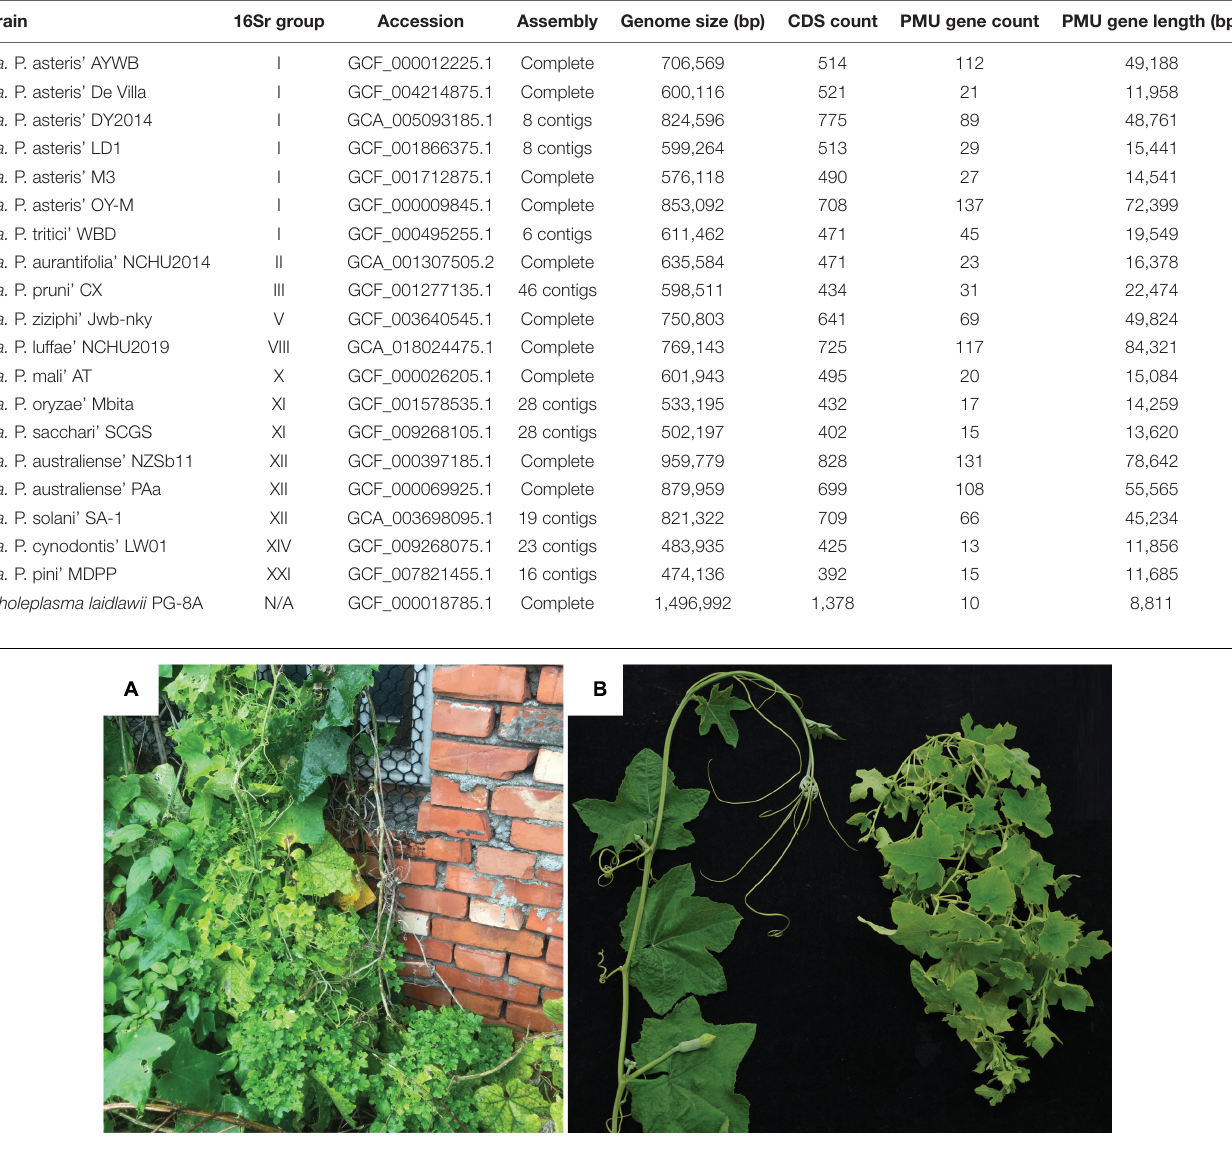
TABLE 1 | List of the genome assemblies analyzed. For each strain, information regarding the 16S rRNA gene (16Sr) group, genome accession number, assembly status, genome size, coding sequence (CDS) count, potential mobile unit (PMU) gene count, and combined length of PMU genes are provided. The PMU gene information is based on homologs of eight core genes (i.e., tra5 , dnaB , dnaG , tmk , hflB , himA , ssb , and rpoD ), including full-length genes and putative pseudogenes. A complete list of these genes is provided in Supplementary Table 1 . Other genes located in proximity, such as those encoding hypothetical proteins or putative secreted proteins, are excluded. Acholeplasma laidlawii is included as an outgroup.